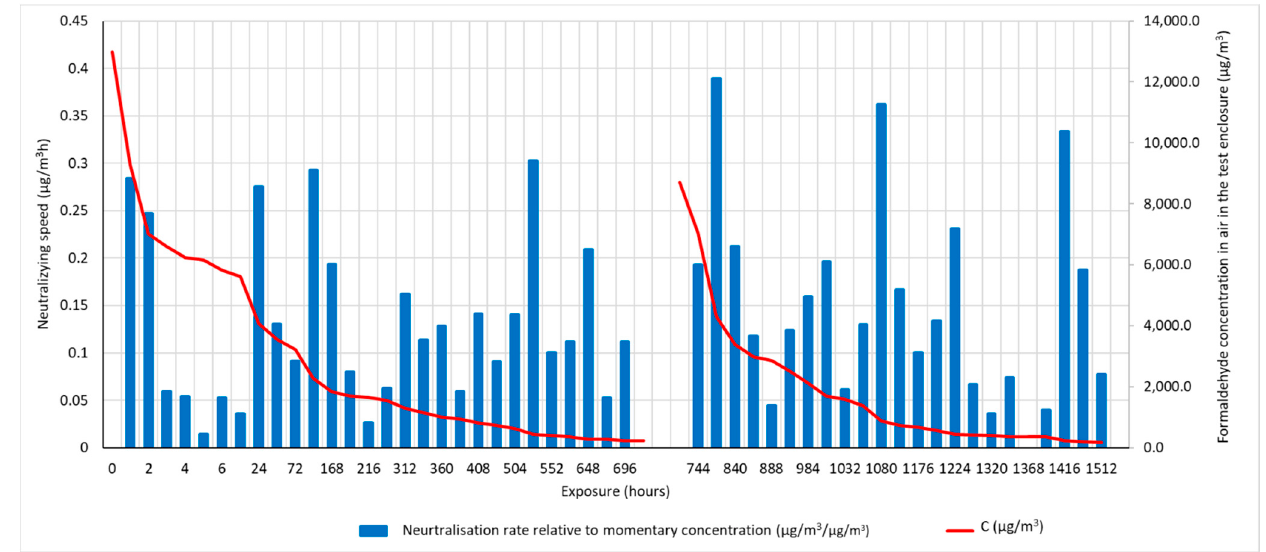
Figure 11. Variation over time in formaldehyde concentration in the air in the room where the heat-insulating mattress was placed and its neutralisation rate (neutralisation rate relative to the momentary concentration represents the amount of formaldehyde neutralised from time t of measurement to time t + 1 of measurement, relative to the formaldehyde concentration existing at time t).